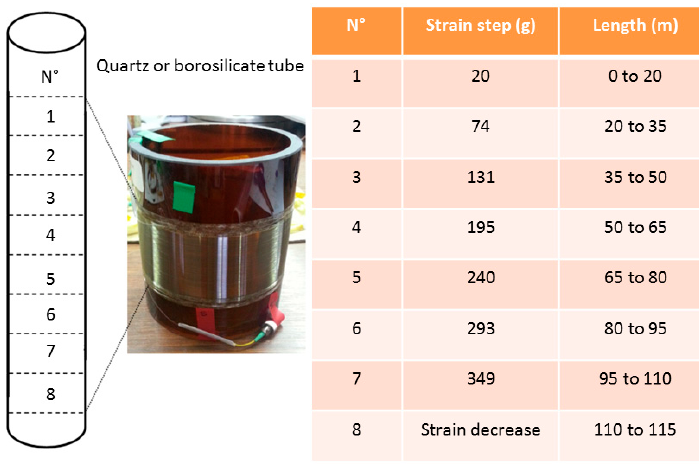
Figure 7. Schematic representation of the fibre coiling and picture of fibre sample strain steps. Borosilicate holder darkened under irradiation.